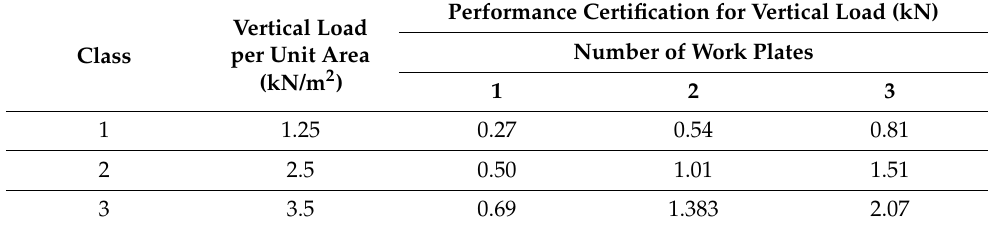
Table 20. Calculation of suggested safety certification standards for fabricated mobile scaffold for horizontal loads based on